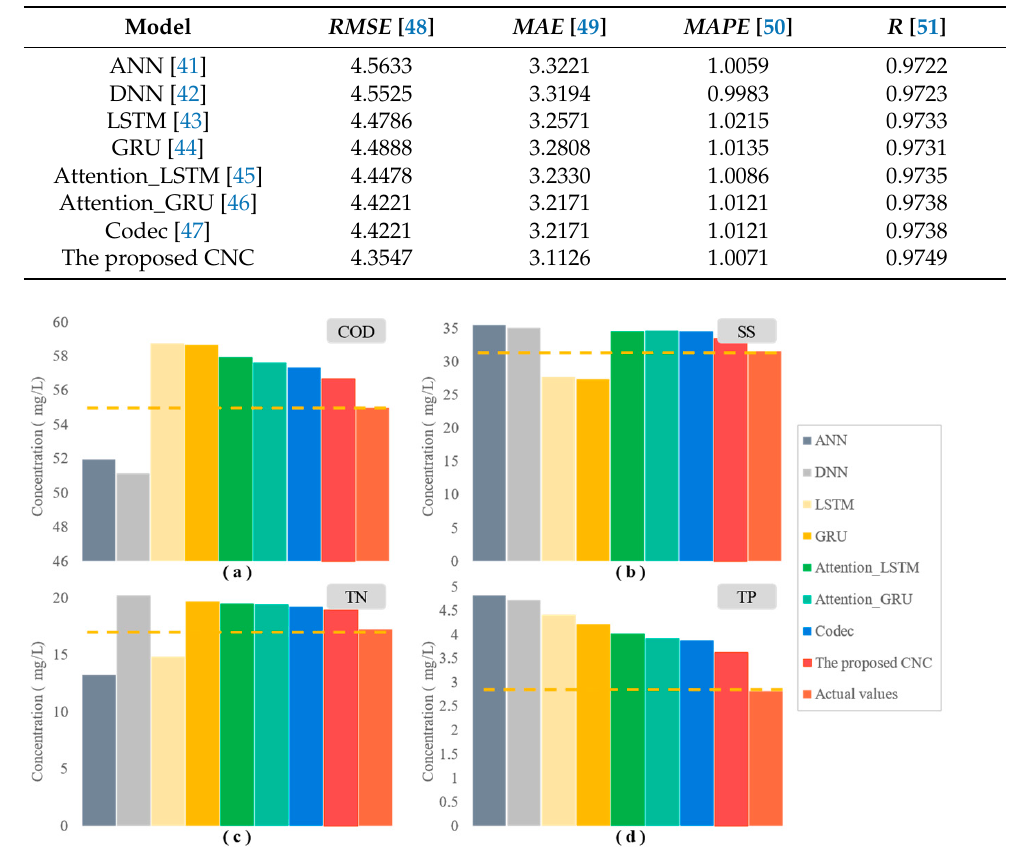
Figure 6. Comparison of predicted and actual values given by the model, based on four pollutant indicators. ( a ) Chemical oxygen demand, ( b ) suspended solids, ( c ) total nitrogen, ( d ) total phosphorus. The last orange-red band is the actual ground-truth value, and the prediction results of all methods are compared using dashed lines. It can be seen that the red band (the method proposed in this paper) is the closest to the actual value.